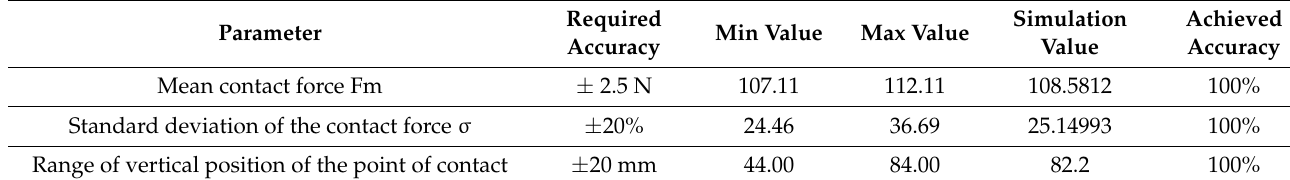
Table 5. Comparison of Melton series 1 simulation output to validation criteria showing acceptable results.